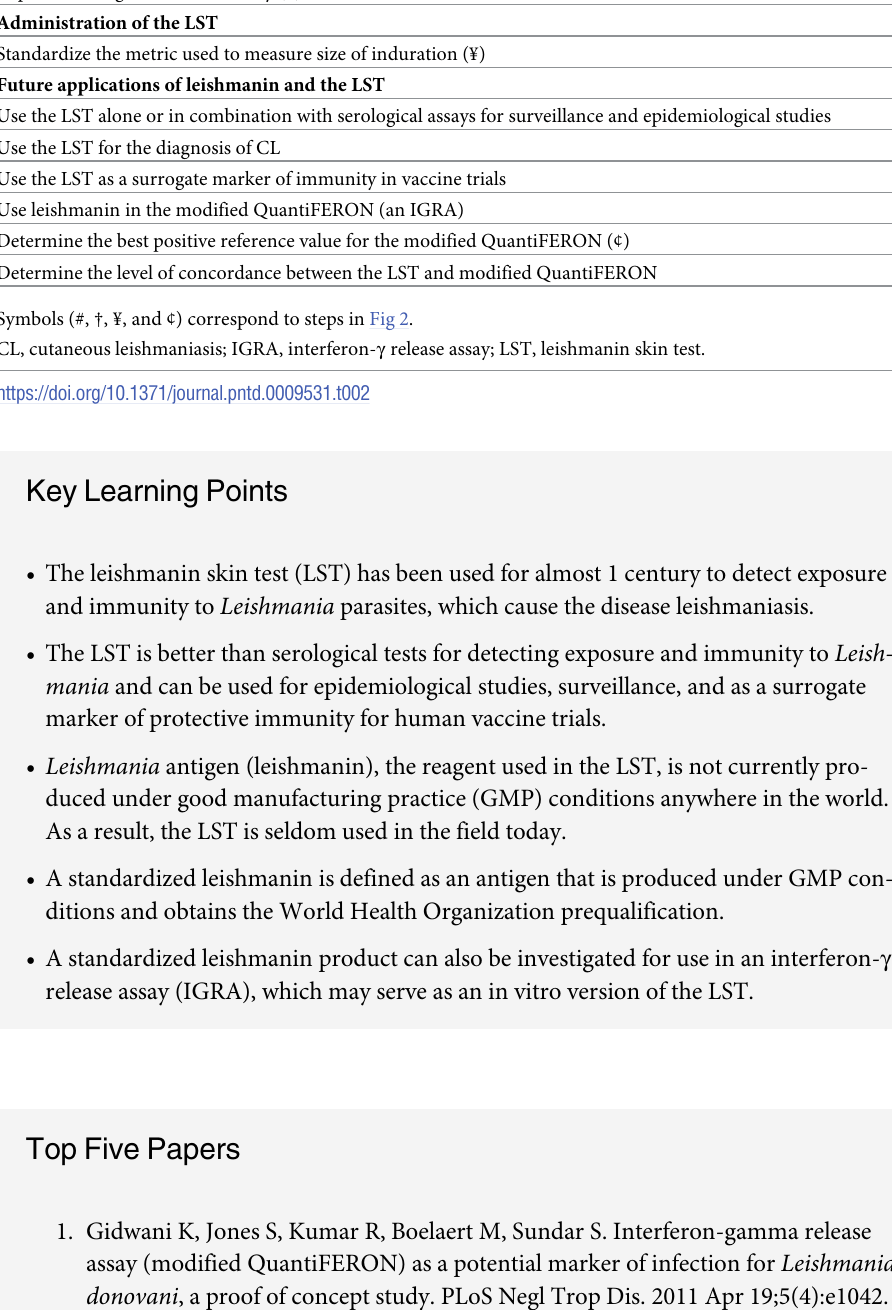
Table 2. Recommendations AU : PleasenotethatasperPLOSstyle ; allcolumnsneedheadings : Hence ; pleaseprovidetableheadingforTable 2 for future development and studies. Standardization of the production and storage of leishmanin Determine cross-reactivity of Leishmania species in leishmanin preparations (#) Establish standardized methodology for production of leishmanin under GMP guidelines (#) Standardize the use of safe preservatives in leishmanin and determine whether lyophilization of leishmanin improves storage and heat stability (†) Administration of the LST Standardize the metric used to measure size of induration (¥) Future applications of leishmanin and the LST Use the LST alone or in combination with serological assays for surveillance and epidemiological studies Use the LST for the diagnosis of CL Use the LST as a surrogate marker of immunity in vaccine trials Use leishmanin in the modified QuantiFERON (an IGRA) Determine the best positive reference value for the modified QuantiFERON (¢) Determine the level of concordance between the LST and modified QuantiFERON Symbols (#, †, ¥, and ¢) correspond to steps in Fig 2. CL, cutaneous leishmaniasis; IGRA, interferon- γ release assay; LST, leishmanin skin test.